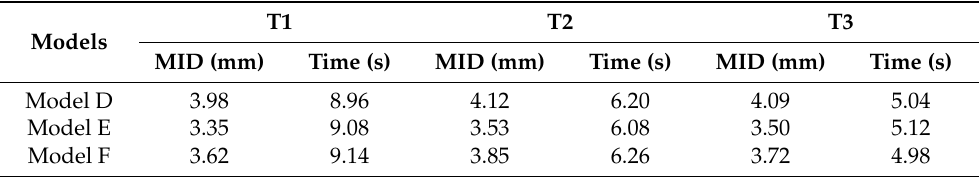
Table 13. The maximum interlayer displacement in the Y-direction.